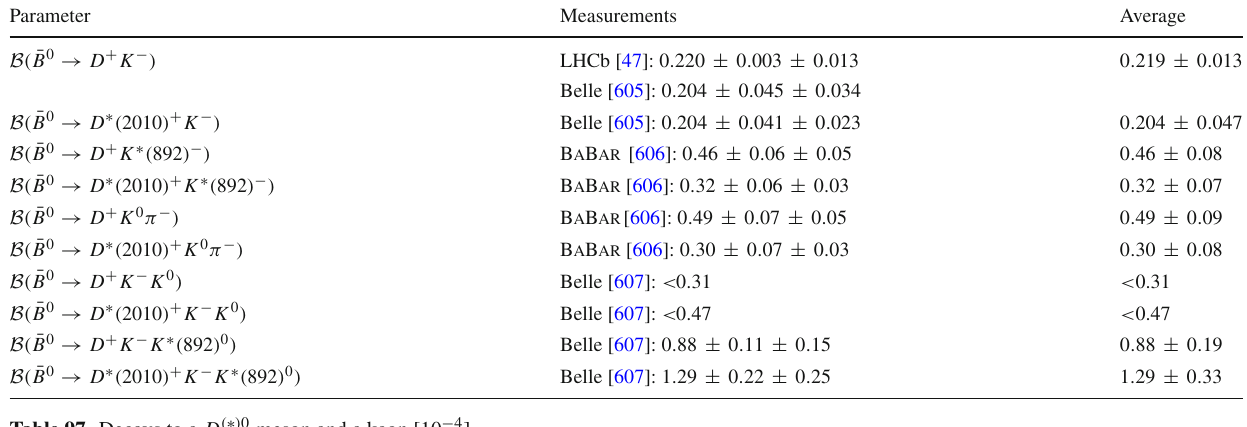
Table 97 Decays to a D ( ∗ ) 0 meson and a kaon [ 10 − 4 ] Parameter